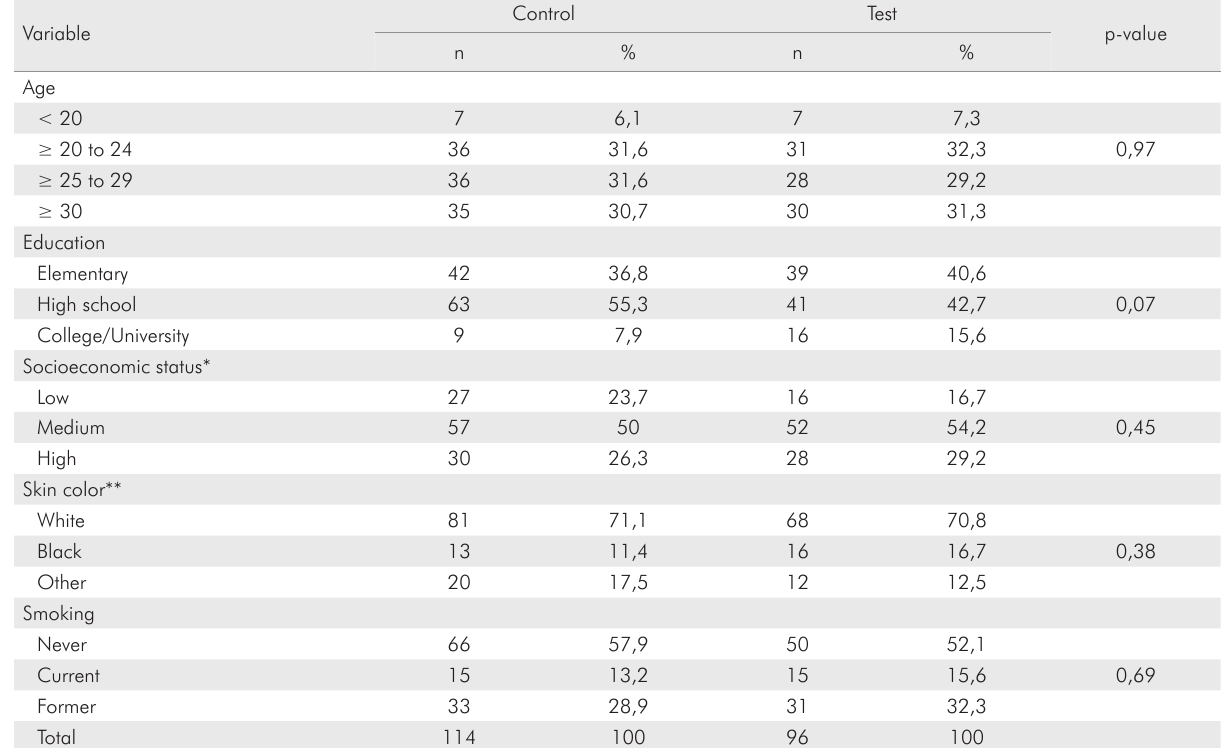
Table 1. Demographics, socioeconomic status and behavioral information at baseline for women completing the study. Variable